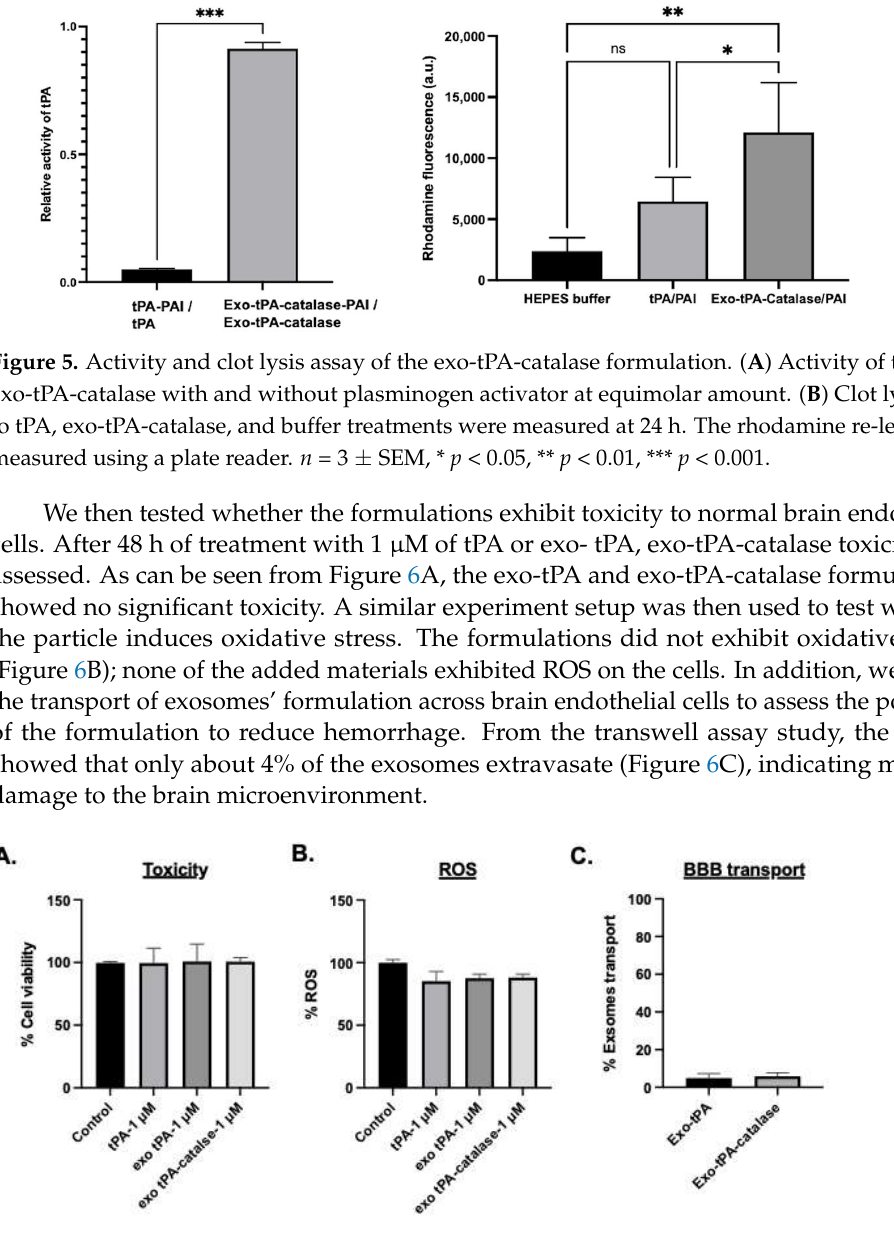
Figure 6. ( A , B ) Exo-tPA and exo-tPA-catalase toxicity and ROS to normal cells were assessed with Alamar Blue and DCFH-DA assay. n = 3 ± SEM. ( C ) Vascular transport of exosomes. Exosomes’ permeability was quantified by comparing the initial exosomes’ concentration at the apical